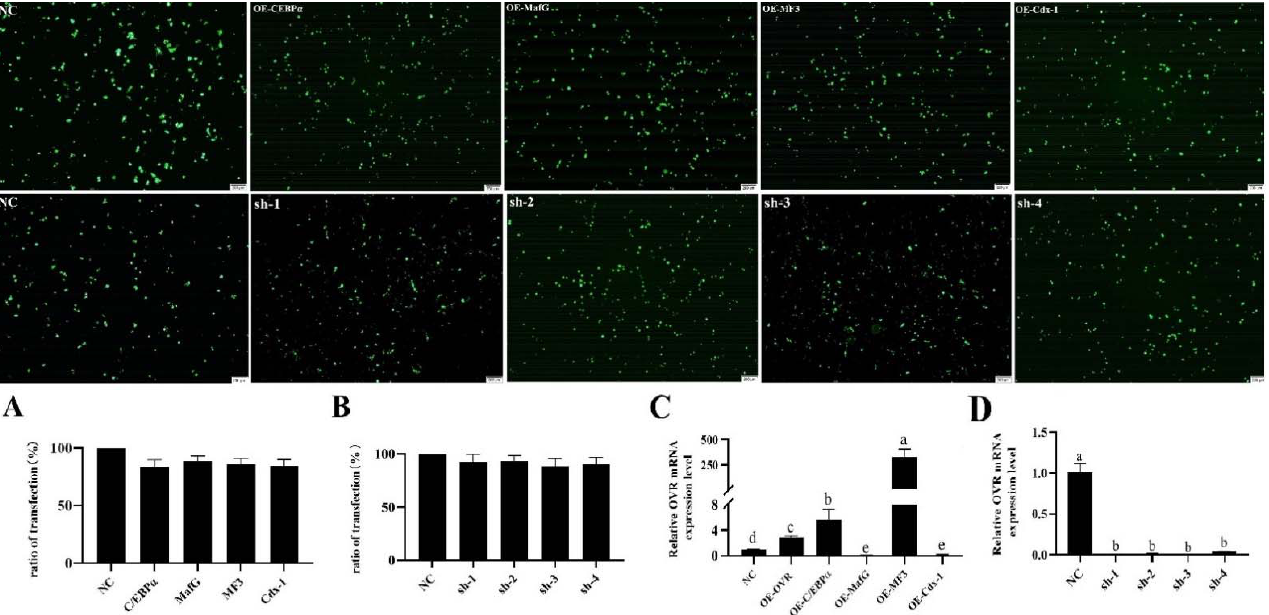
Figure 5. Vector transfection efficiency and OVR expression in each transfected group. NC: negative control; OE ‐ C/EBP α : granulosa cells transfected with overexpressed C/EBP α vector; OE ‐ MafG: granulosa cells transfected with overexpressed MafG vector; OE ‐ MF3: granulosa cells transfected with overexpressed MF3 vector; OE ‐ Cdx ‐ 1: granulosa cells transfected with overexpressed Cdx ‐ 1 vector. sh ‐ 1, sh ‐ 2, sh ‐ 3 and sh ‐ 4 mean granulosa cells transfected with OVR knockdown vectors. ( A ) Granulosa cells transfected with each over ‐ expressed vector. ( B ) Granulosa cells transfected with each OVR knock ‐ down vector. ( C ) Relative OVR expression in each overexpressed vector. ( D ) Rel ‐ ative OVR expression in each OVR knock ‐ down vector.